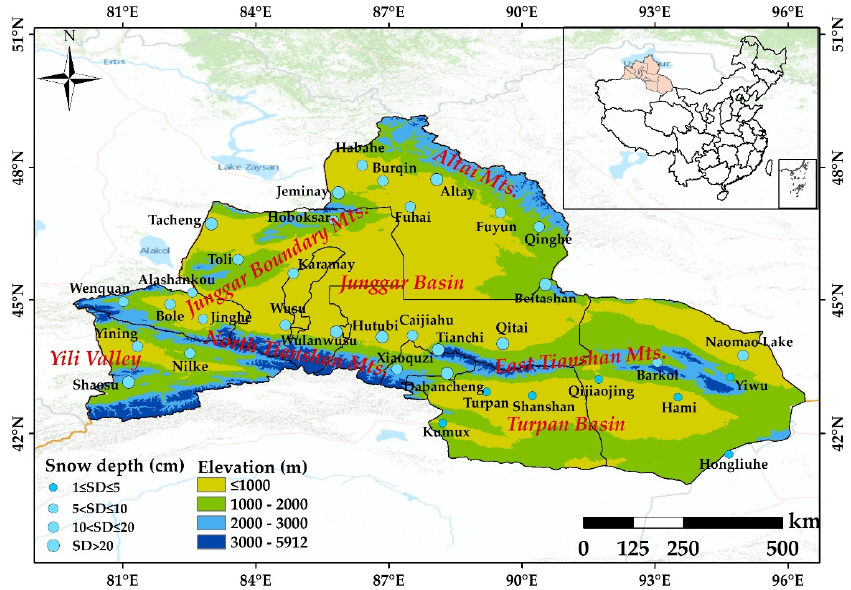
Figure 1. Location of the study area of Northern Xinjiang (NX) in China and geomorphological features. The figure is based on the Standard Map NO. GS (2016) 2923, downloaded from the Ministry of Natural Resources in China (http://bzdt.ch.mnr.gov.cn/). SD is the abbreviation of snow depth, which means the average snow depth of the observa- tion stations in winter. MWRI was launched onboard the Fengyun 3B (FY3B) satellite, which is mainly used to detect precipitation rate, water content of cloud, water quantity, total water vapor, soil moisture, sea ice, temperature and snow cover for the research of water cycle and energy transfer at global and hemispherical scales (http://satellite.nsmc.org.cn). The main pa- rameters of the sensor are listed in Table 1. The resolution of different frequencies ranges from 9 km to 85 km, and each frequency has two modes of vertical polarization and horizontal polarizations. The mean accuracy of sensor is 2 K, which is lower than the accuracy of 1 K of AMSR-2. The MWRI Level 1 BT data were downloaded for the snow seasons from 2011 to 2016 and were used to construct the downscaling snow depth model, data from four snow seasons (2011.11.1–2014.3.31, 2015.11.1–2016.3.31) were used to train the model, and data from 1 November 2014 to 31 March 2015 with few extreme abnormal weather were chosen to validate and evaluate model accuracy. In this manu- script, the official ascending and descending orbit snow depth datasets were denoted as MWRI_A and MWRI_D, respectively and were used to compare with the spatial distri- bution of downscaled snow depth. The high-frequency and low-frequency polarimetric data of ascending and de- scending orbit are the main inputs to construct the downscaling snow depth model. Original BT data were resampled to 500 m resolution with nearest-neighbor interpola- tion to match snow cover data, meteorological and geographic data. Based on the longi- tude and latitude information of national meteorological stations, the pixel BT data of specific coordinates are extracted for modeling and analysis [43].